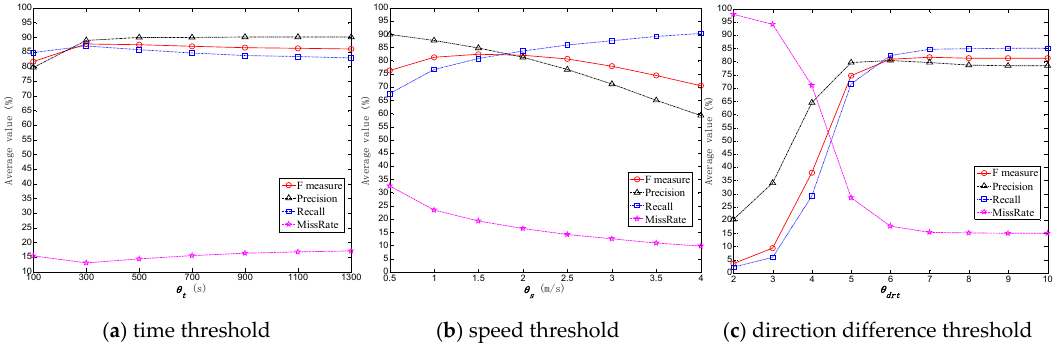
Figure 8. The running results on DS1 . In this figure, the parameters of LPEX and SPEX algorithms are changed.